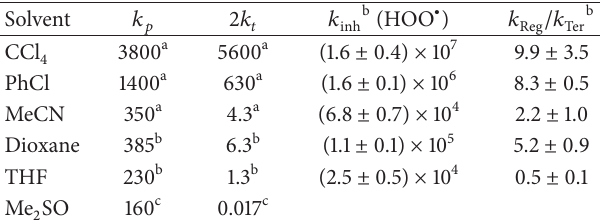
/𝑘 /M −1 s −1 and 𝑘 ) at inh Reg Ter